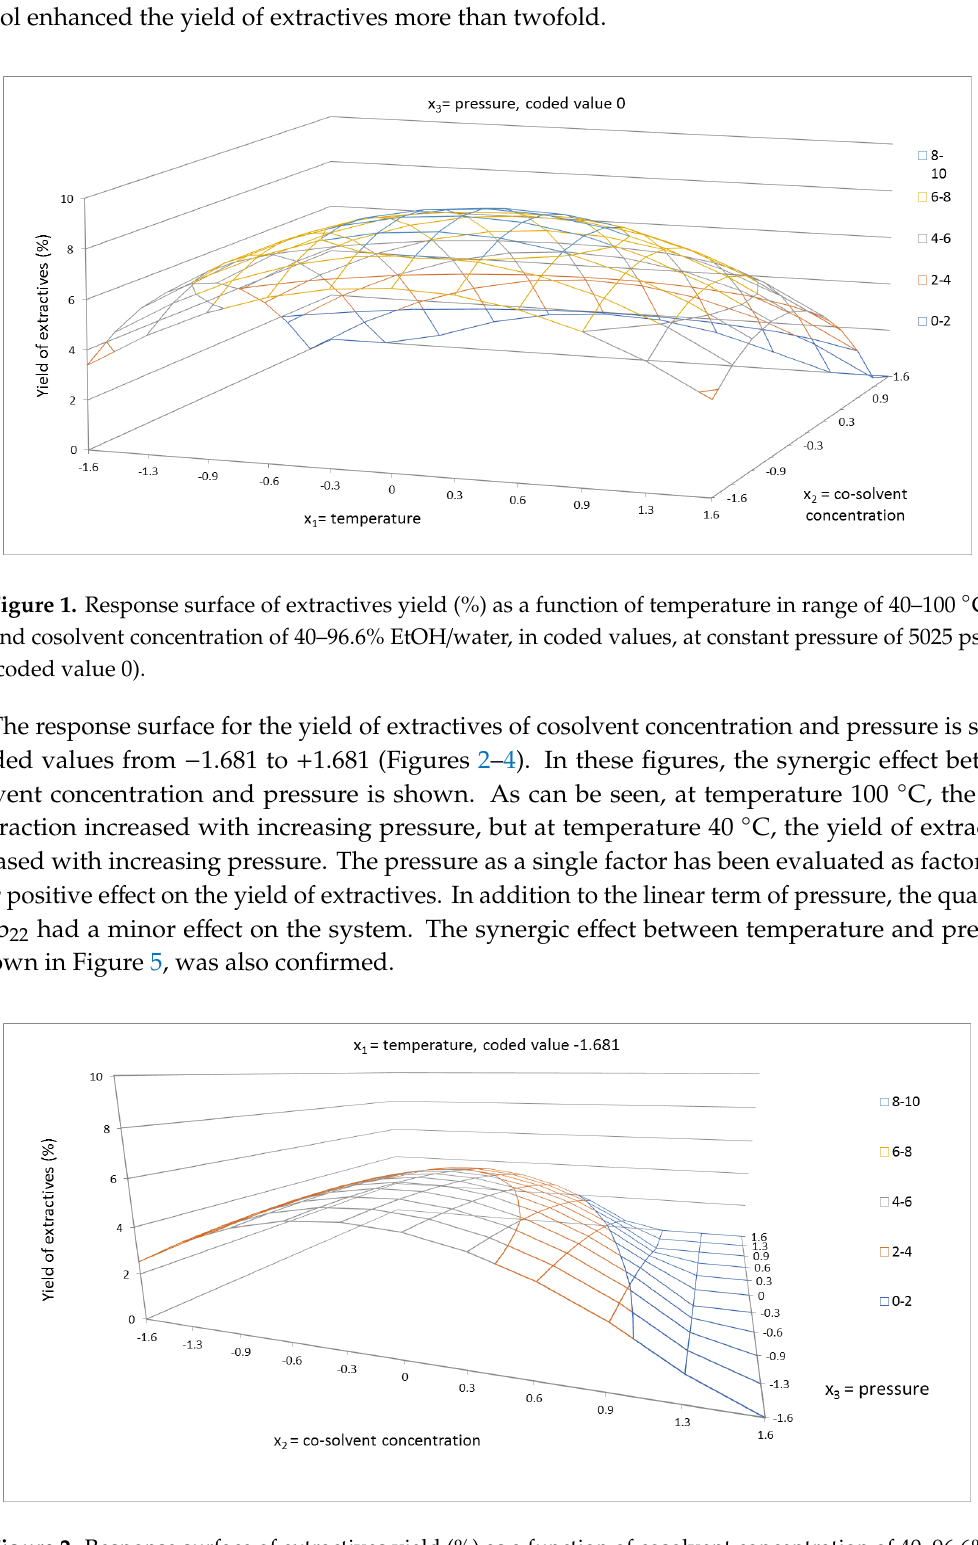
Figure 3. Response surface of extractives yield (%) as a function of cosolvent concentration of 40– 96.6% EtOH/water and pressure in the range of 1050–9000 psi, in coded values, at constant temperature of 70 °C (coded value 0).